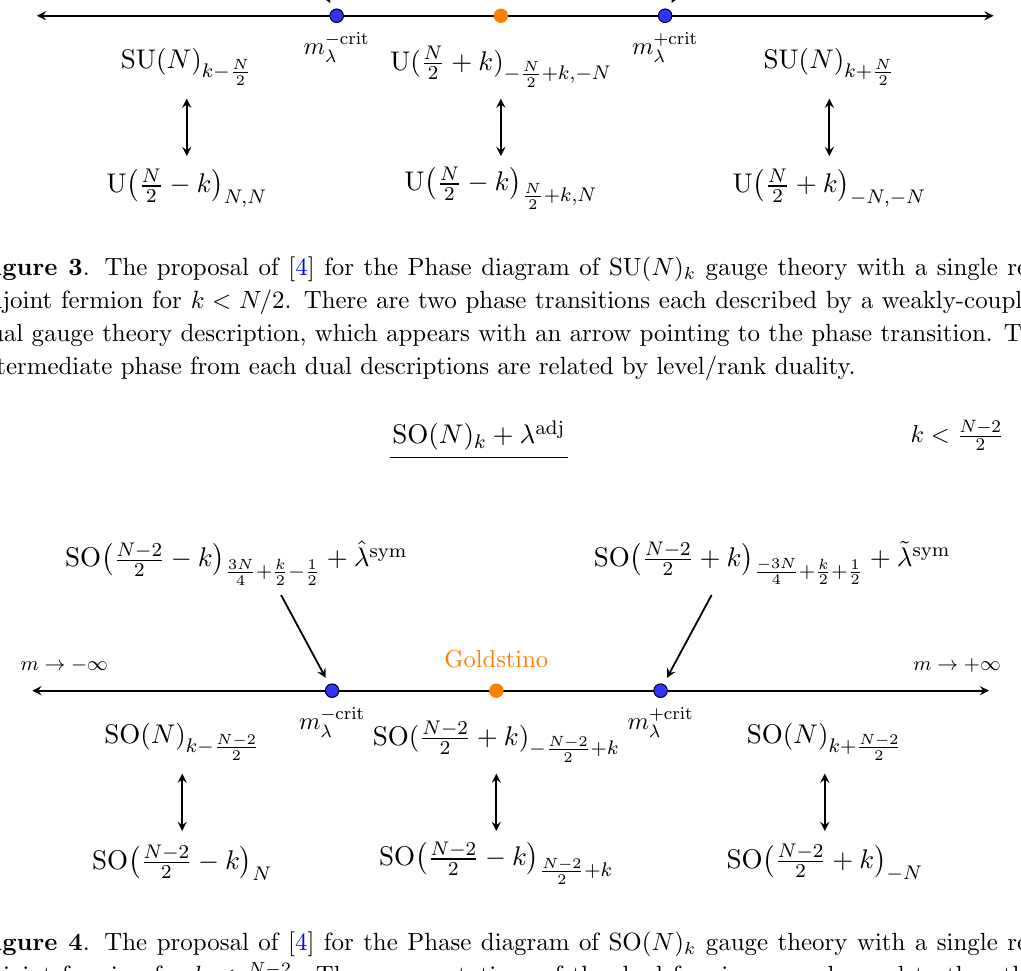
Figure 4 . The proposal of [4] for the Phase diagram of SO( N ) k gauge theory with a single real adjoint fermion for k < N (cid:0) 2 . The representations of the dual fermions are changed to the other 2 rank-two representation of the gauge